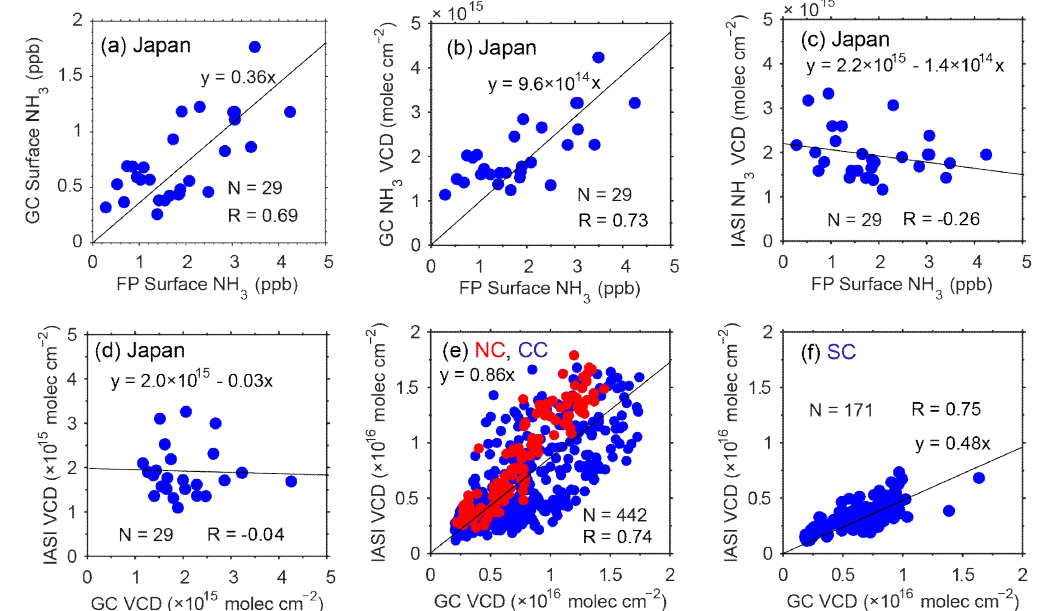
Figure 6. Scatter plot of ( a ) FP and GEOS-Chem surface NH 3 , ( b ) FP surface NH 3 and GEOS-Chem NH 3 VCD, ( c ) FP surface NH 3 and IASI NH 3 VCD, and ( d ) IASI and GEOS-Chem NH 3 VCD on grids with FP observations, ( e ) IASI and GEOS-Chem NH 3 VCD for the North China (NC) and central China (CC), and ( f ) IASI and GEOS-Chem NH 3 VCD for the South China (SC). N is the number of data and R is the correlation coefficient.